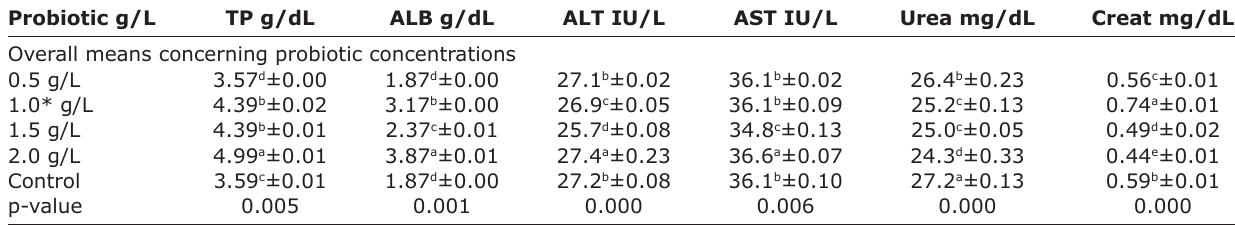
Table-5: Biochemical parameters (mean±SE) in broilers supplemented with different concentrations of probiotics. Probiotic g/L TP g/dL ALB g/dL ALT IU/L Overall means concerning probiotic concentrations